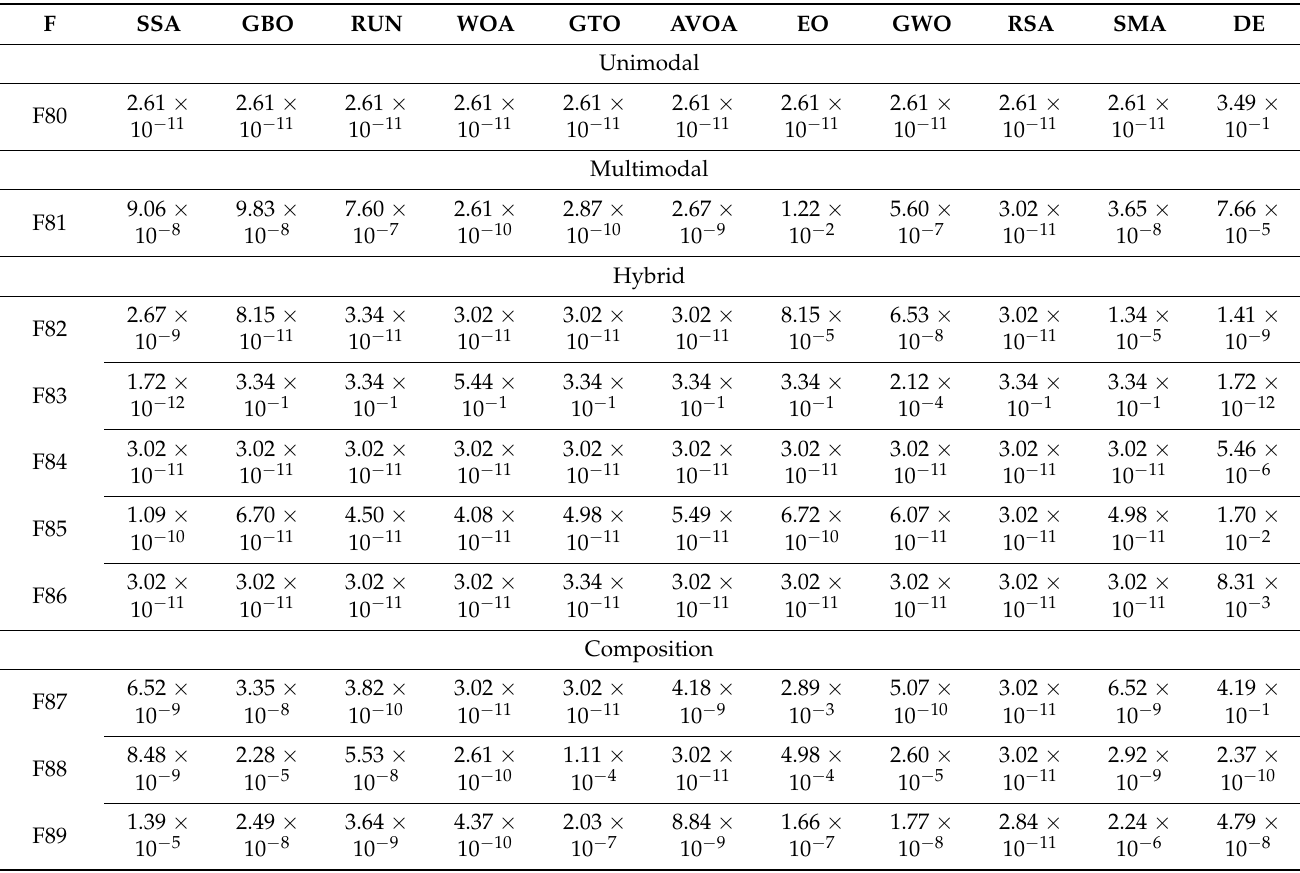
Table 13. p -values of LSO with each rival optimizer on CEC-2020 test suite